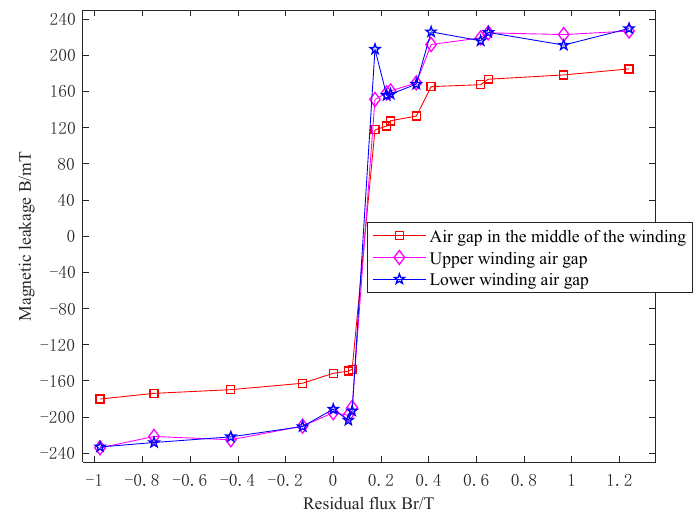
Figure 22. Air gap leakage curve under different residual flux.